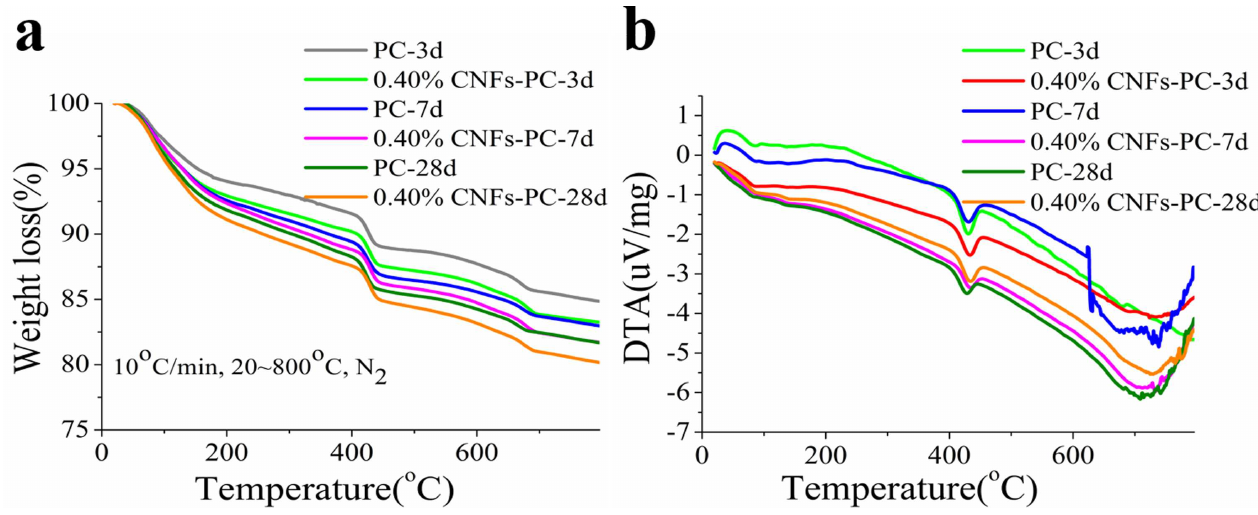
Fig 4. DTA-TGA results of cement pastes with different CNF weight fractions from 100 to 800˚C.